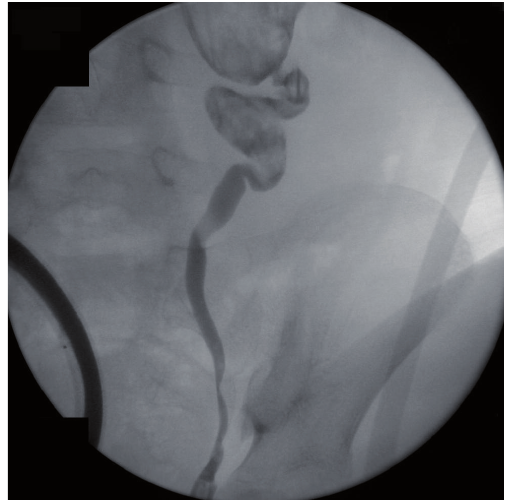
Figure 2: A retrograde pyelogram prior to surgery shows opaci- fication of the dilated left renal collecting system with abundant internal debris noted within the renal pelvis and proximal ureter. The ureteropelvic junction appears narrowed, though obstruction elsewhere along the ureter and dilating reflux cannot be ruled out.